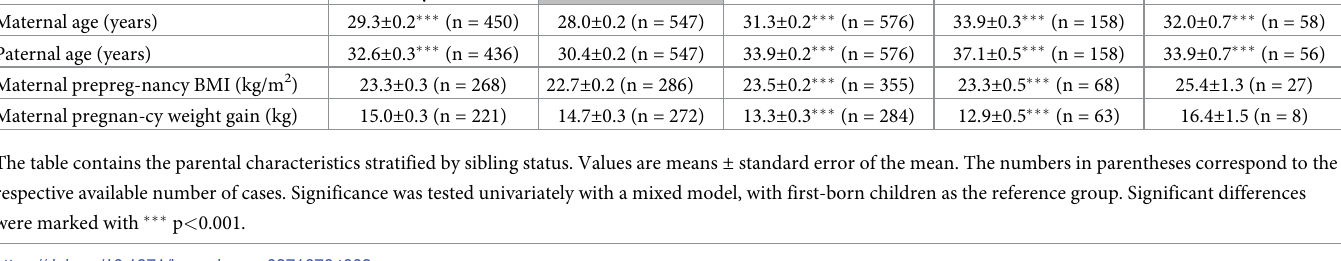
Table 2. Parental characteristics by sibling status.